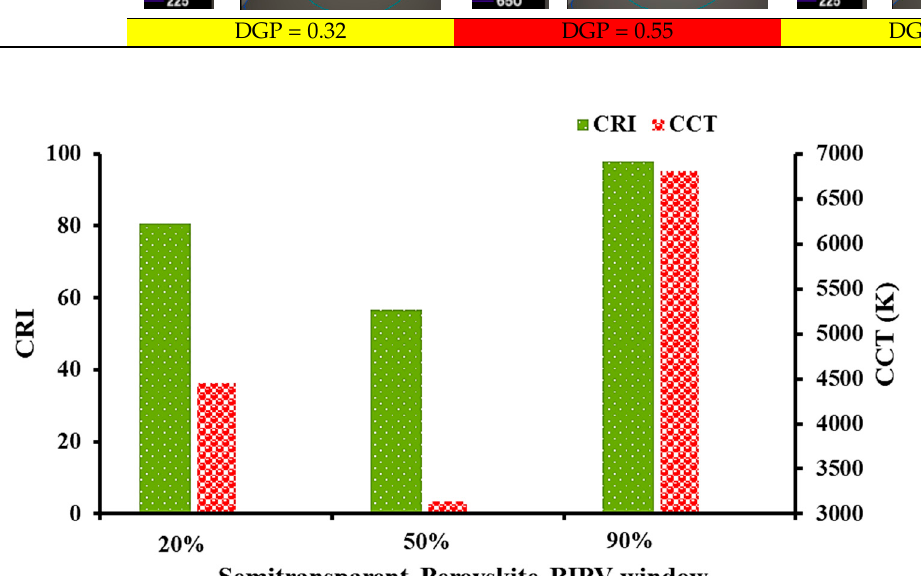
Figure 5. CCT and CRI analysis to evaluate colour comfort using three different transparent Perovskite based BIPV window.